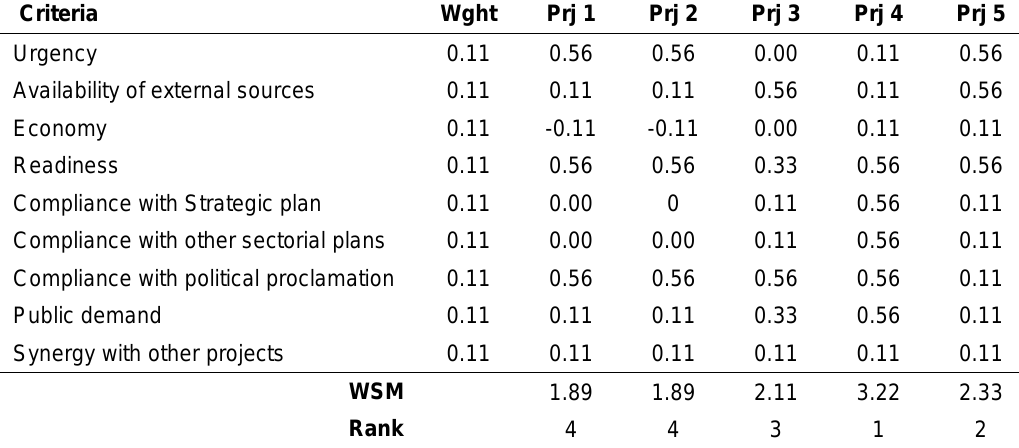
Table 7. Results of projects comparison with interval points